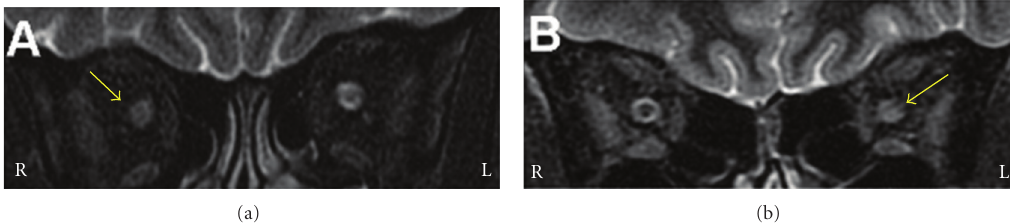
Figure 1: Coronal images of the orbits of two patients with acute right (a) and left (b) optic neuritis obtained with an inversion recovery (STIR) sequence. (a) The anterior part of the right optic nerve is swollen. The perioptic space is less obvious. (b) The posterior portion of the left optic nerve is bright and swollen. Yellow arrows: a ff ected optic nerve. L and R: left and right.